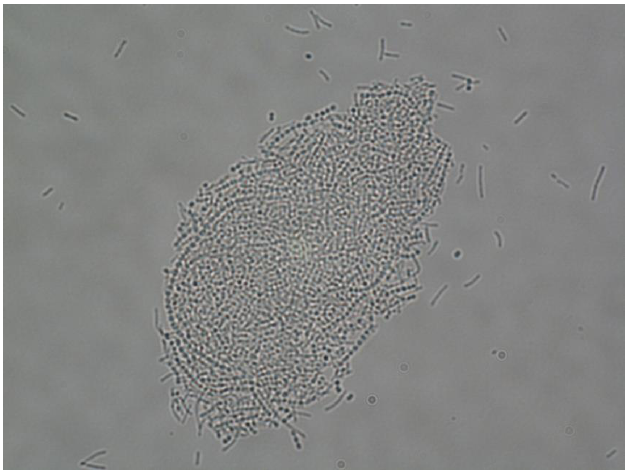
Figure 1. The strong co-aggregation between L. salivarius CECT 9145 (rods) and an S. agalactiae strain (cocci chains).